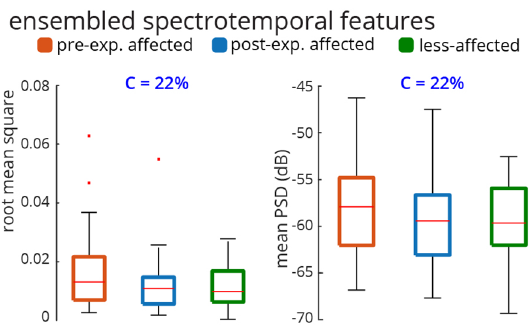
Figure 3. Ensembled RMS and PSD across n = 32 subjects. For each subject, the median RMS values across all sEMG electrodes, all conditions, and all trials are quantified. Thus, there is a distribution of 32 ensembled RMSs for 32 subjects. The same method is used for generating the distribution of ensembled PSD (considering 20 to 200 Hz). The Friedman test was not significant for either RMS or PSD of sEMG (RMS: Friedman Chi 2 ( 2,62 ) = 4.75, p = 0.0930 , PSD: Friedman Chi 2 ( 2,62 ) = 3.25, p = 0.1969 ). The conformity ratio was equal for both RMS and PSD (C = 22%).